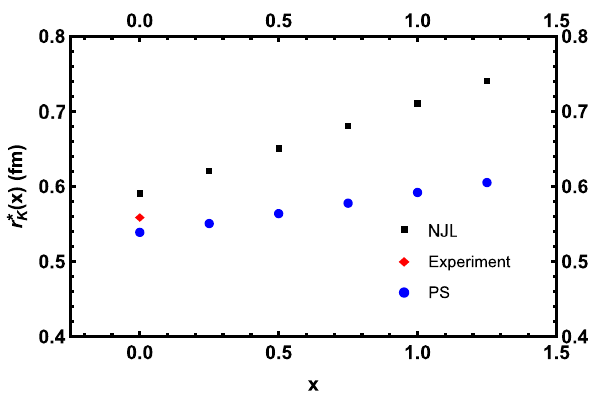
Fig. 10 The variation of the ratio of the density dependent electromag- netic form factor to the vacuum one with respect to the density of the medium at average value of Q 2